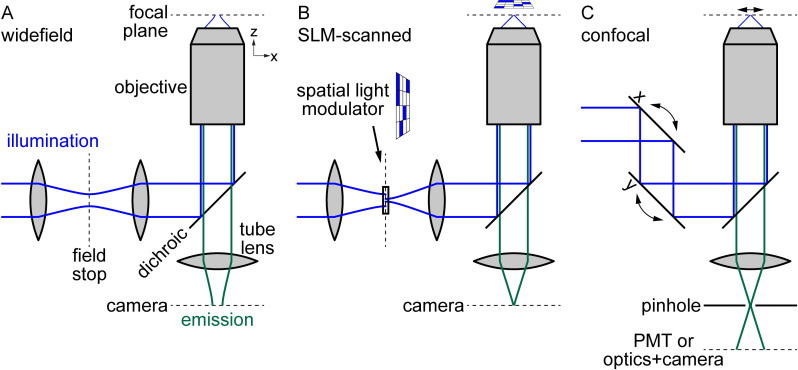
Optics and light beampaths for microscope setups.(A) Widefield illumination optics create field stop plane, whose light distribution is projected to focal plane in sample via objective. Camera images emission light from focal plane. (B) Introduction of SLM at field stop masks illumination light and allows arbitrary illumination patterns at focal plane. (C) Confocal microscope optics scan illumination beam and utilize pinhole to exclude out-of-focus emission light.